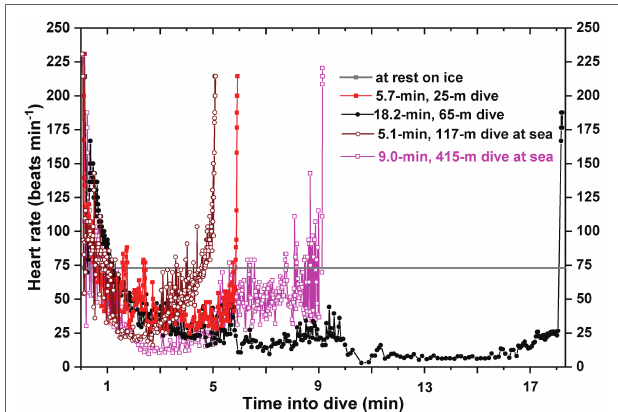
FIGURE 1 | Beat-to-beat heart rate profiles of emperor penguins diving either at an experimental isolated dive hole in McMurdo Sound, Antarctica, or during foraging trips at sea from Cape Washington, Antarctica. Heart rate profiles were characterized by an immediate decline from high pre-dive levels [200–240 beats min − 1 (bpm)], a continued gradual decline to below-resting levels over the initial 1 to 2 min, and then a further progressive decline as dive duration increased. In the bottom phase of long dives and deep dives, heart rates could be as low as 5–10 bpm. Ascents were characterized by a gradual increase in heart rate. Heart rate profiles were characterized by abrupt oscillations in heart rate throughout the dive. Heart rate at rest was about 72 bpm. Adapted from the data of Meir et al. (2008) and Wright et al. (2014).